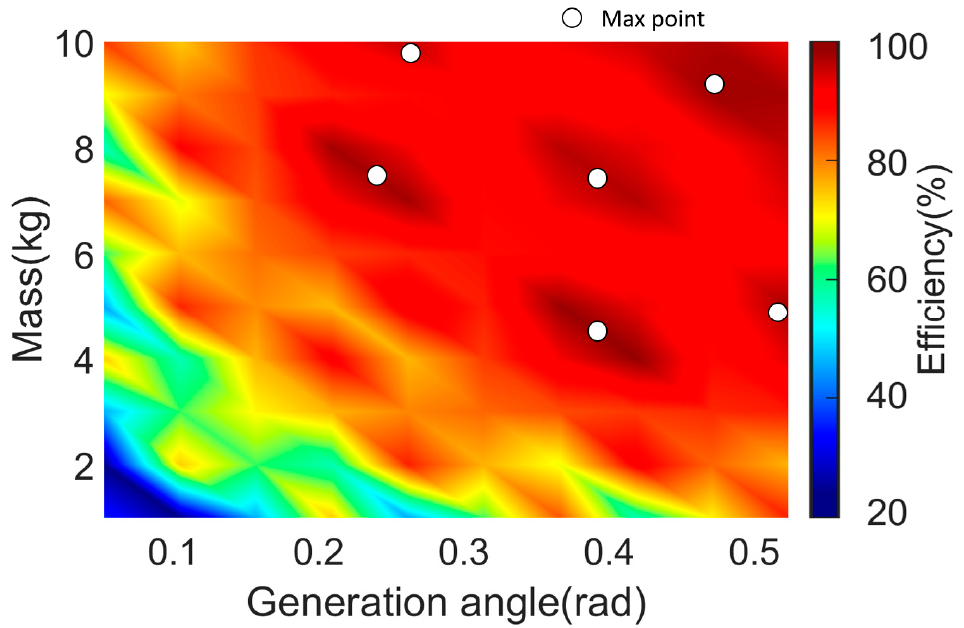
Figure 6. Generation efficiency according to 𝛼 and pendulum length.